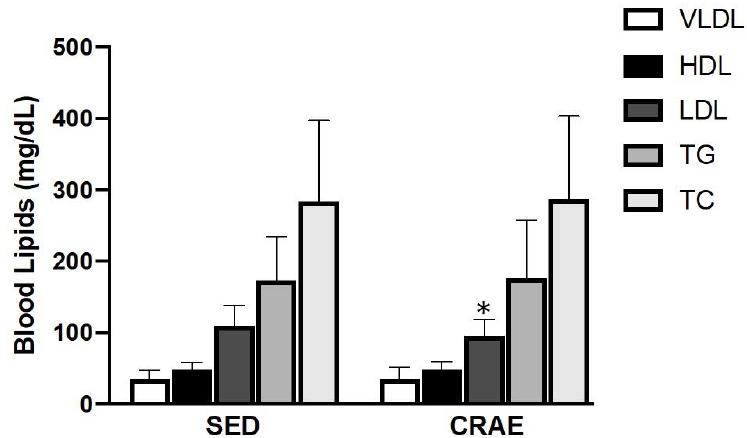
Figure 3. Differences in blood lipids including very low-density lipoprotein (VLDL), high-density lipoprotein (HDL), low-density lipoprotein (LDL), triglycerides (TG), and total cholesterol (TC) between the combined resistance and aerobic exercise training (CRAE) and sedentary (SED) groups. LDL was significantly lower in the CRAE group compared to the SED group (110.9 ± 27.7 vs. 94.9 ± 23.5 mg/dL, SED vs. CRAE, respectively; p = 0.023). There were no differences in VLDL (35.1 ± 12.2 vs. 35.4 ± 16.6 mg/dL, SED vs. CRAE, respectively; p = 0.37), HDL (48.3 ± 9.8 vs. 47.9 ± 11.7 mg/dL, SED vs. CRAE, respectively; p = 0.44), TG (173.0 ± 61.9 vs. 176.9 ± 80.4 mg/dL, SED vs. CRAE, respectively; p = 0.39), or TC (284.6 ± 112.5 vs. 287.3 ± 116.9 mg/dL, SED vs. CRAE, respectively; p = 0.47). Values are Mean ± SD. * p < 0.05 vs. SED. Table 3. Participant characteristics in the sedentary (SED) and combined resistance and aerobic exercise (CRAE) groups. Total Participants ( n = 101) SED ( n = 44) Age, y